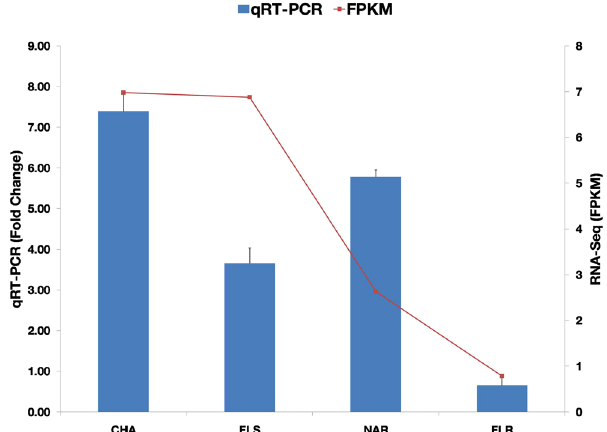
Figure 10. Validation of gene expression by qRT-PCR. CHA is Chalcone Isomerase, FLS (Flavonol Synthase), NAR (Naringenin 3-dioxygenase) and FLR is Flavonone 4-